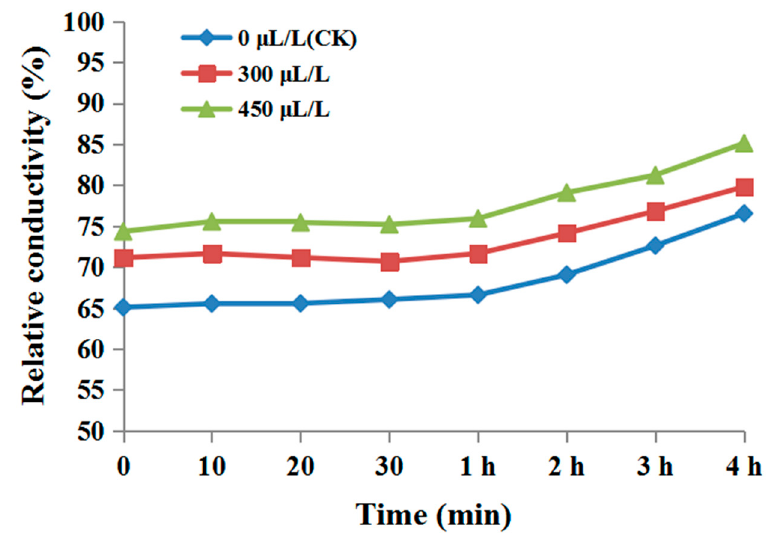
Figure 3. E ff ect of DADS on relative conductivity of P. nicotianae Figure 3. Effect of DADS on relative conductivity of P. nicotianae mycelia. Figure 3. Effect of DADS on relative conductivity of P. nicotianae mycelia.